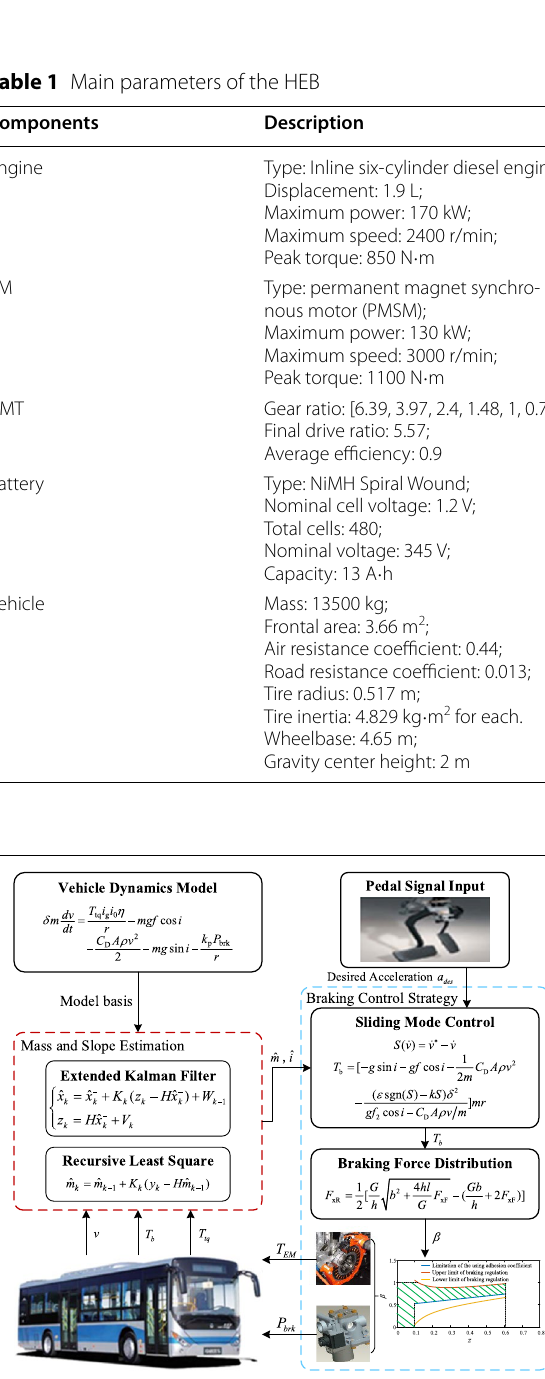
Figure 2 Overall architecture of the proposed method